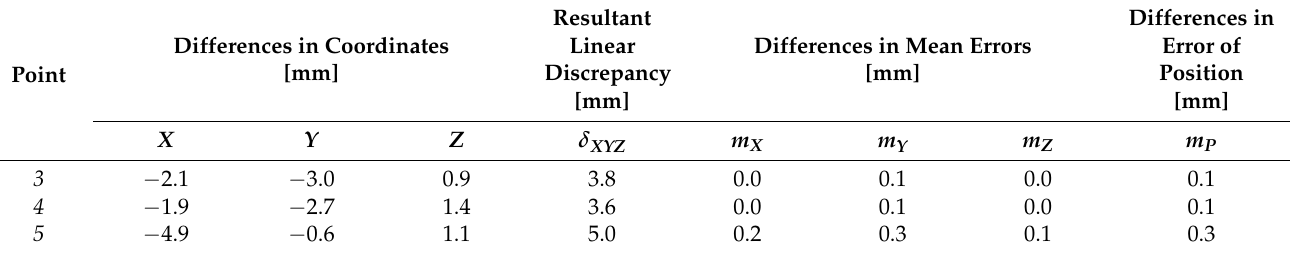
Table 8. Comparison of results of adjustments of the GNSS network and the integrated network.